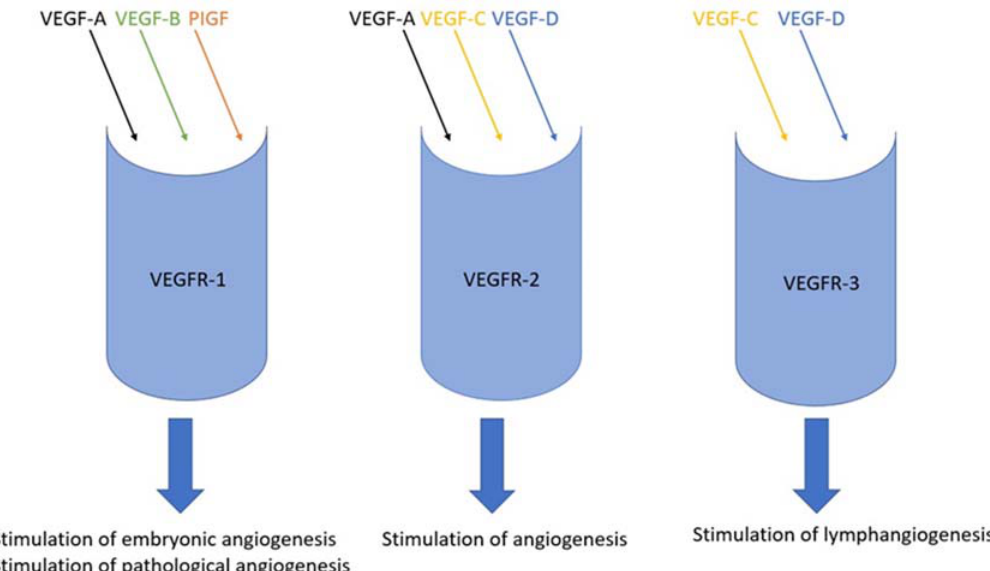
Figure 1. The possible combinations of bindings of VEGF family factors to individual receptors. In humans, the VEGF ‐ A (also called VEGF) gene at locus 6p21.3 is part of a group of genes that encode a cluster of proteins called the cystine ‐ knot growth factor superfamily, which also includes PDGF, NGF and TGF ‐β . VEGF is a glycoprotein with a heterodimer structure in which the cystine node has a characteristic arrangement of disulfide bridges.